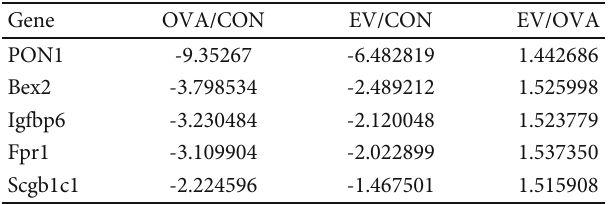
Table 2: Genes upregulated following treatment with ASC-derived